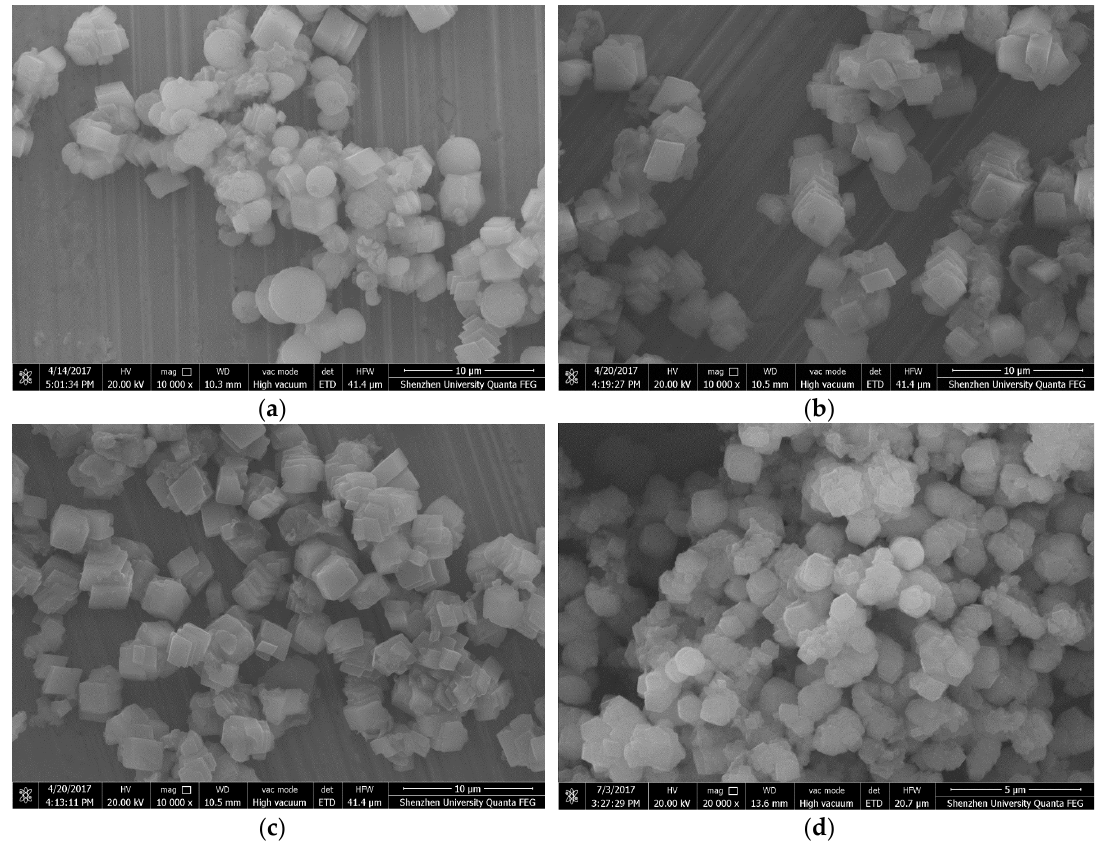
Figure 4. Environmental scanning electronic microscope (ESEM) images of CaCO 3 crystals prepared with different mass ratios of GO: ( a ) No GO, ( b ) 0.2% GO, ( c ) 1% GO, and ( d ) 2% GO.